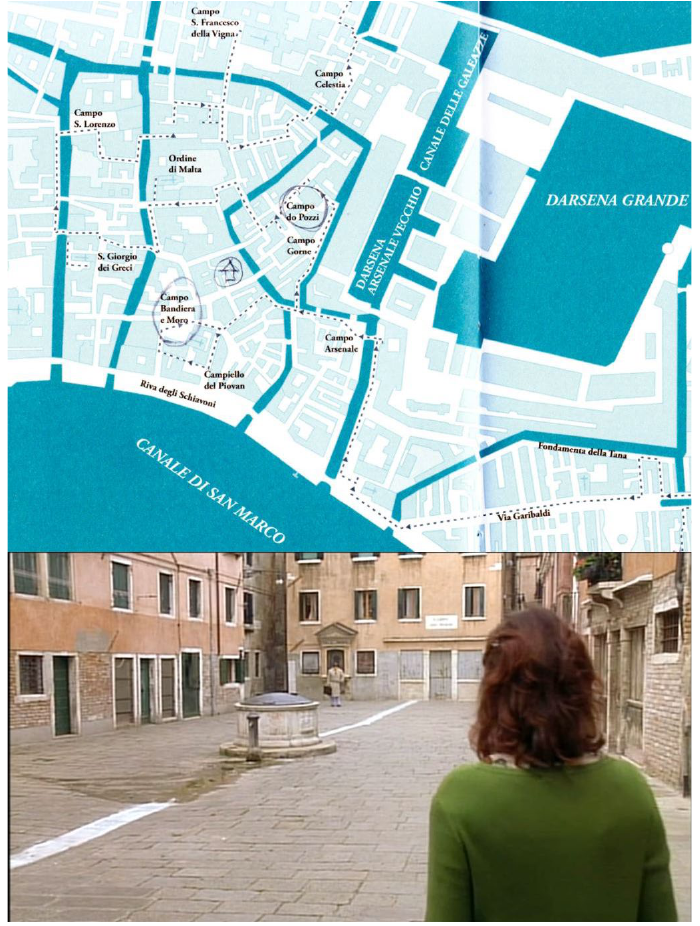
Figure 2 The walk around the Arsenale in Corto Maltese’s Guide to Venice – Below a still from Rosalba and Constantino meeting in Campo do Pozzi in Pane e Tulipani [Bread and Tulips] (Soldini, Italy,